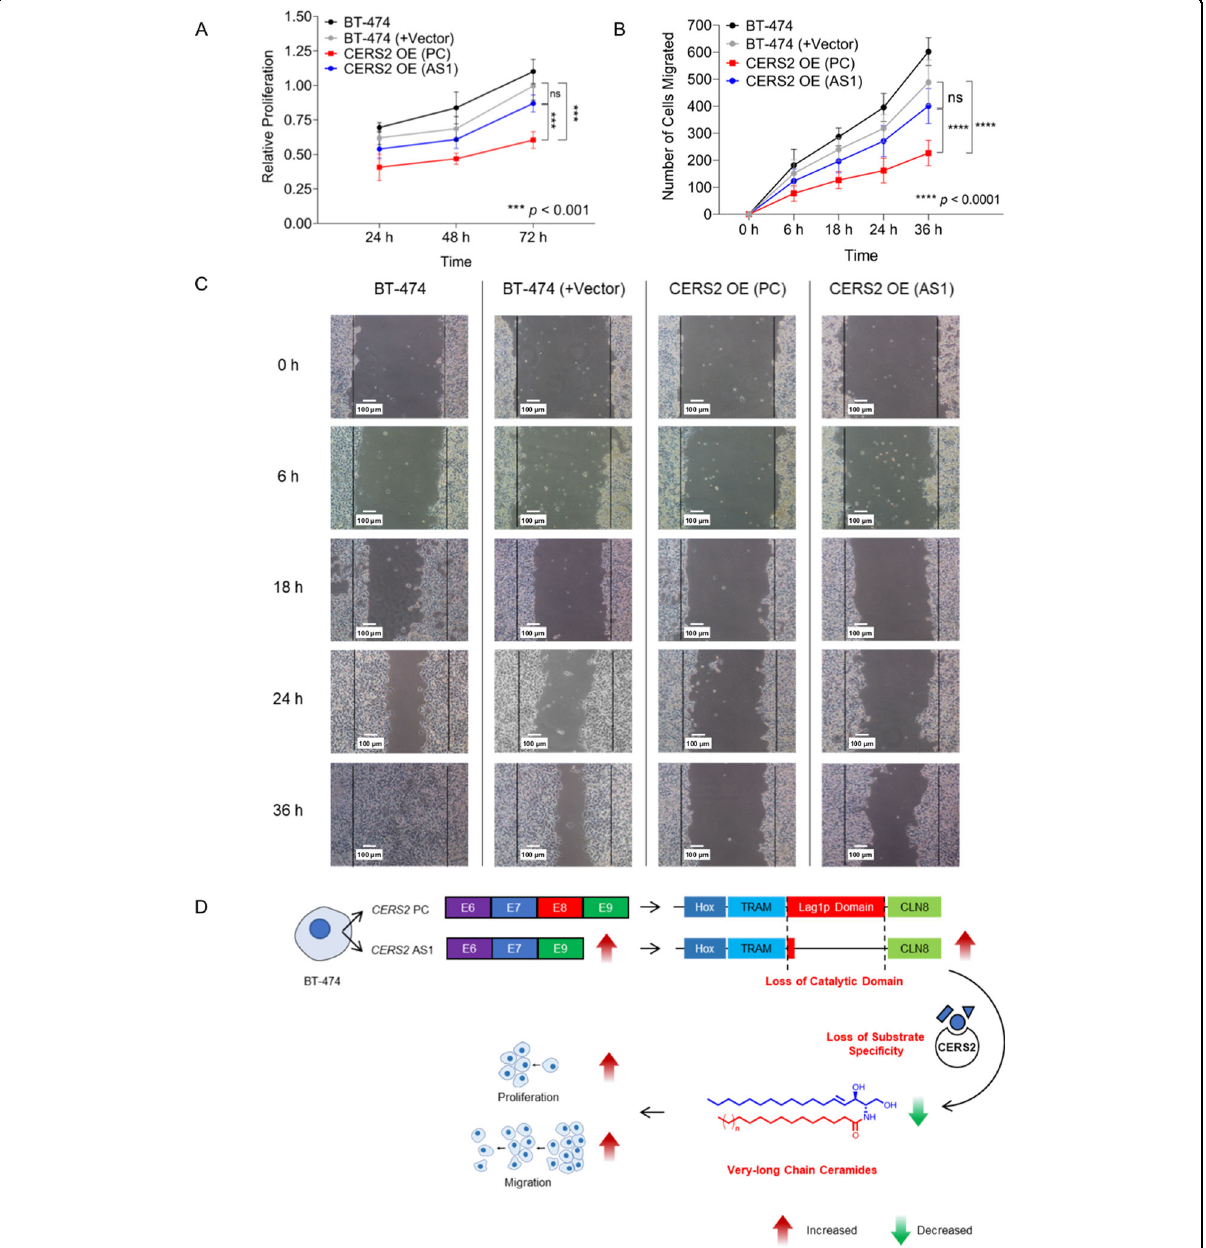
Fig. 7 Overexpression of CERS2 transcript (AS1) is unable to suppress proliferation and migration of BT-474 cells. A , B Change in proliferation ( A ) (mean ± SD, n = 5) and number of migrating cells ( B ) (mean ± SD, n = 5) shows that overexpression of CERS2 OE (AS1) in BT-474 cells signi fi cantly enhances cell proliferation estimated by MTT assay ( A ) and the number of migrating cells in scratch wound assay ( B ) compared to overexpression of CERS2 OE (PC) cells. C Representative images of wound closure at 0, 6, 18, 24, and 36 h in BT-474, BT-474 ( + Vector), CERS2 OE (AS1), and CERS2 OE (PC) cells. D Model depicting how a post-transcriptional regulatory mechanism affects sphingolipid metabolism in Luminal B subtype- speci fi c cancer cells by downregulating the synthesis of very-long-chain ceramides that facilitate tumor progression by increased cell proliferation and migration. Data in A , B were analyzed using two-way